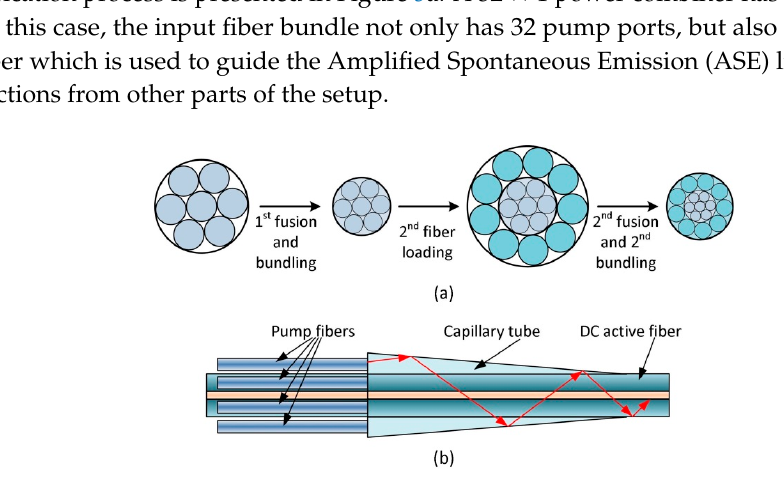
Figure 5. Scheme of double bundling process for fabrication of 16 × 1 power combiner adapted from a paper [56] ( a ) and a side-pump power combiner in 7 × 1 configuration adapted from a paper [52] ( b